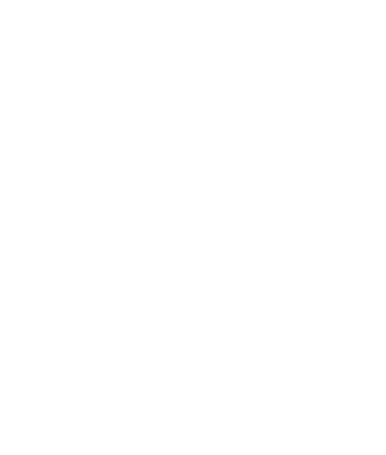
FIGURE 3 | Relationship between progesterone levels and the number of retrieved oocytes in GnRH-a and LE GnRH-ant groups. GnRH-a: gonadotropin-releasing hormone-agonist; GnRH-ant: gonadotropin-releasing hormone-antagonist; P1.5: the proportion of